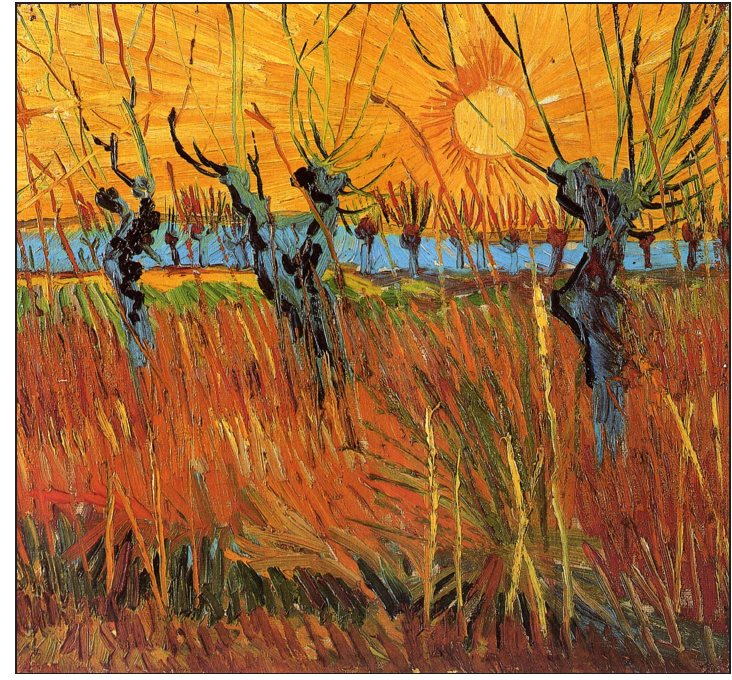
Fig. 6 : Vincent Van Gogh, Pollard Willows at Sunset , 1888, oil on canvas mounted on cardboard, 31.6 × 34.3 cm, Kröller-Müller Museum, Otterlo. Wikimedia